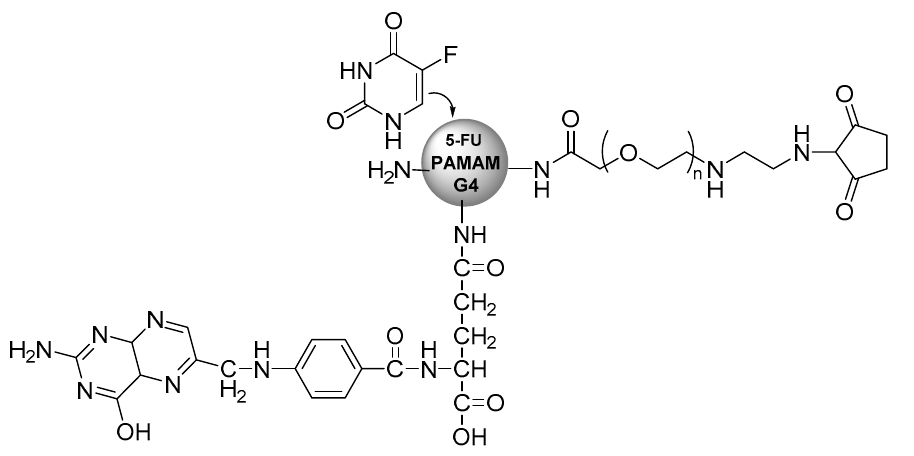
Figure 3. Structure of PAMAM G4 dendrimer platforms as a carrier of 5-fluorouracil.